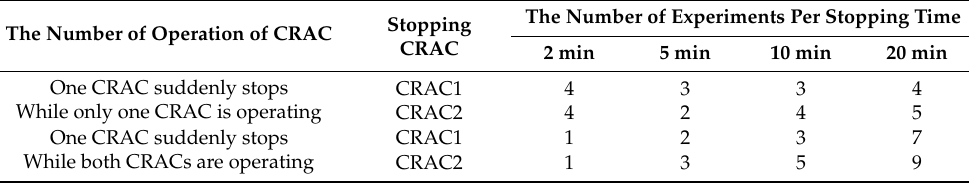
Table 2. CRAC operation patterns and stop